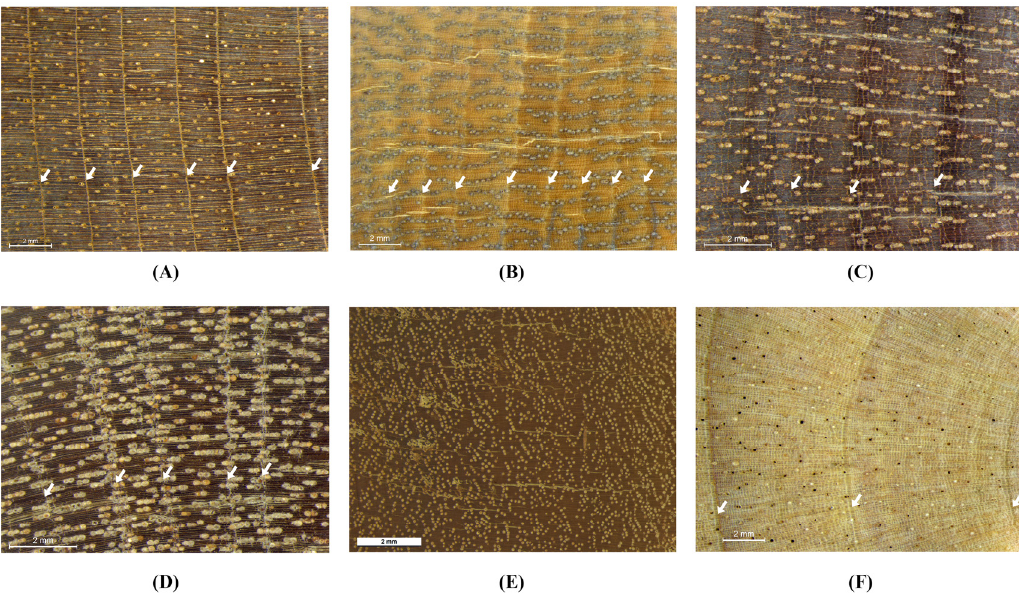
Figure 4. Growth zone types and distinctiveness of growth zones of different tree species from swamp forest ( A – E ) and a non-flooded site ( F ) in Borneo. The samples were polished and the photos taken with a microscope digital camera. The tree ring boundaries are indicated by arrows. ( A ) Horsfieldia crassifolia (marginal parenchyma bands, distinct); ( B ) Diospyros evena (density variations, distinct); ( C ) Palaquium ridleyi (pattern of changing fiber and parenchyma tissue, distinct); ( D ) Tetramerista glabra (varying vessel distributions and parenchyma pattern, distinct); ( E ) Tristaniopsis grandifolia (indistinct); ( F ) Hevea brasiliensis (parenchyma pattern, distinct).